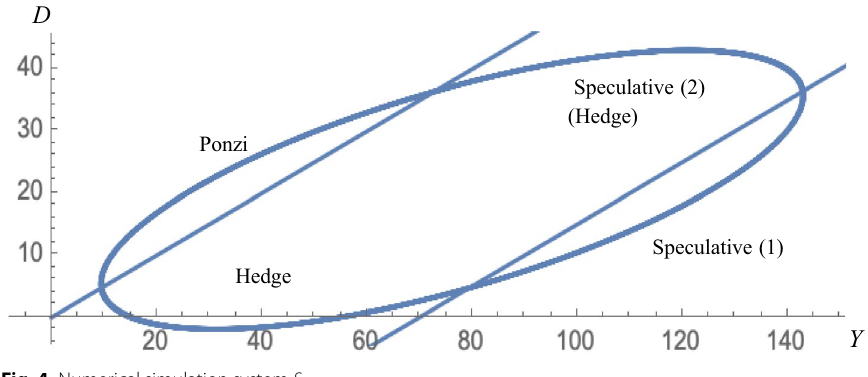
Fig. 4 Numerical simulation system S